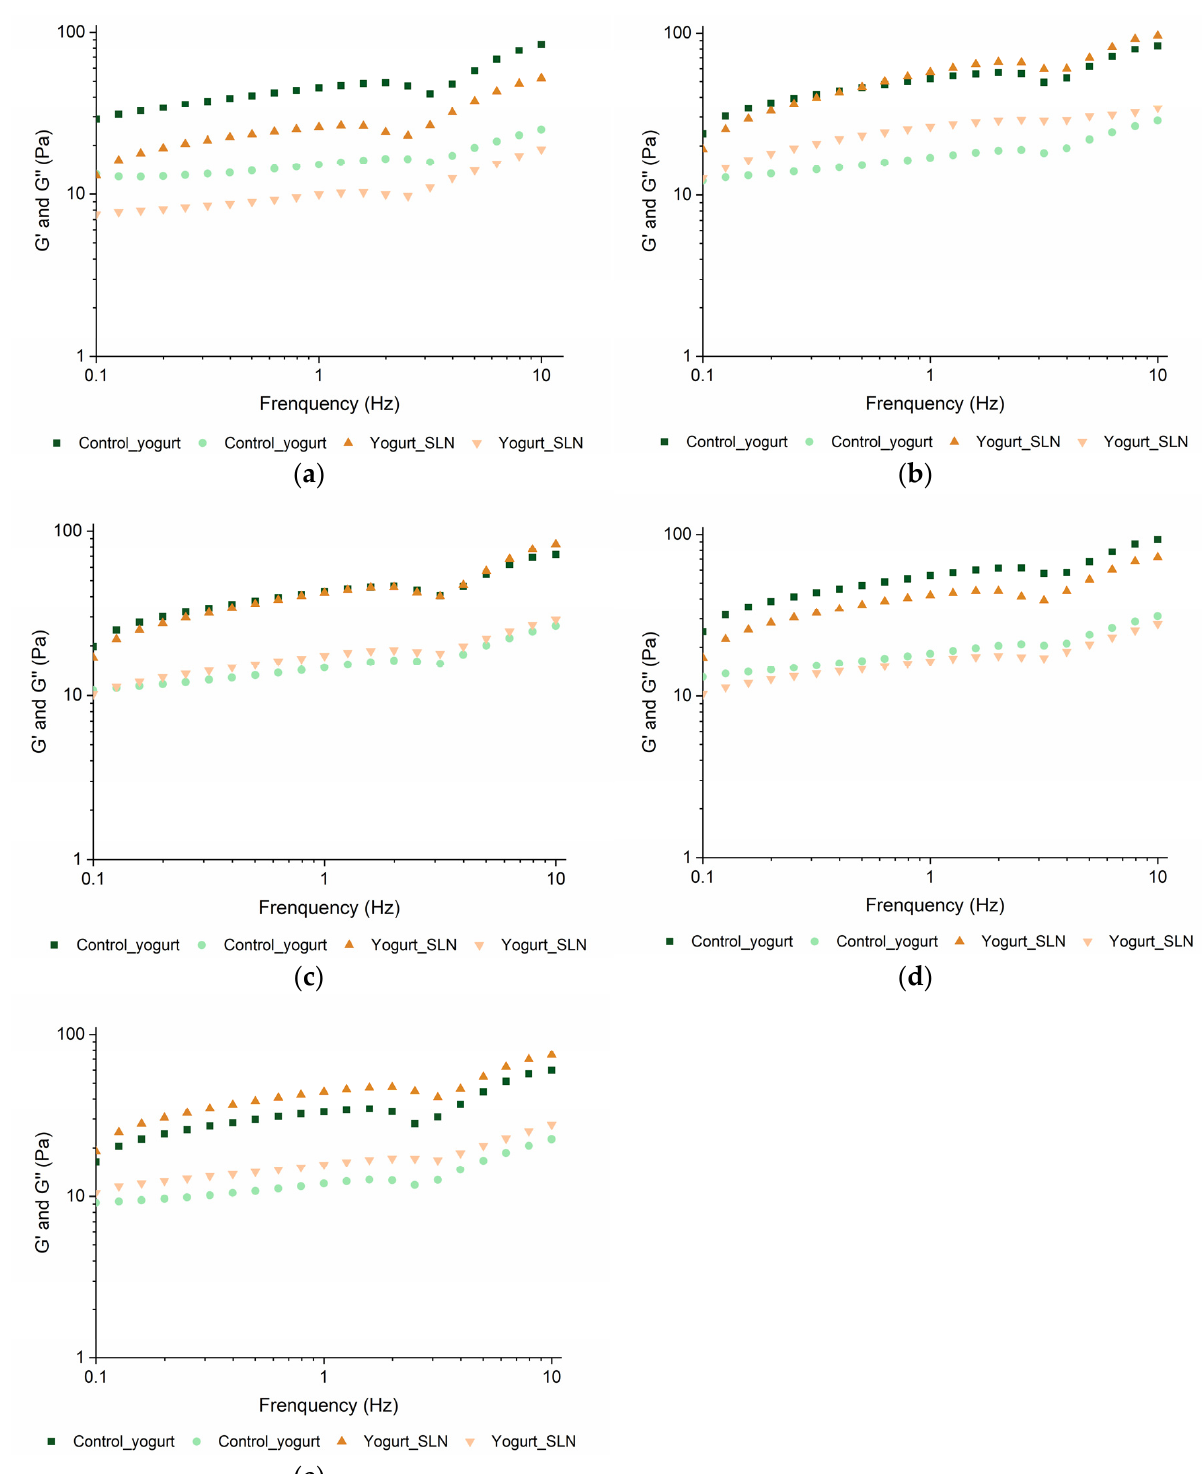
Figure 6. Frequency sweep of yogurt with SLNs and control yogurt (i.e., plain yogurt) at beginning ( a ), 7 days ( b ), 15 days ( c ), 21 days ( d ) and 30 days ( e ). Whereas and represent G’, and represent G’’.